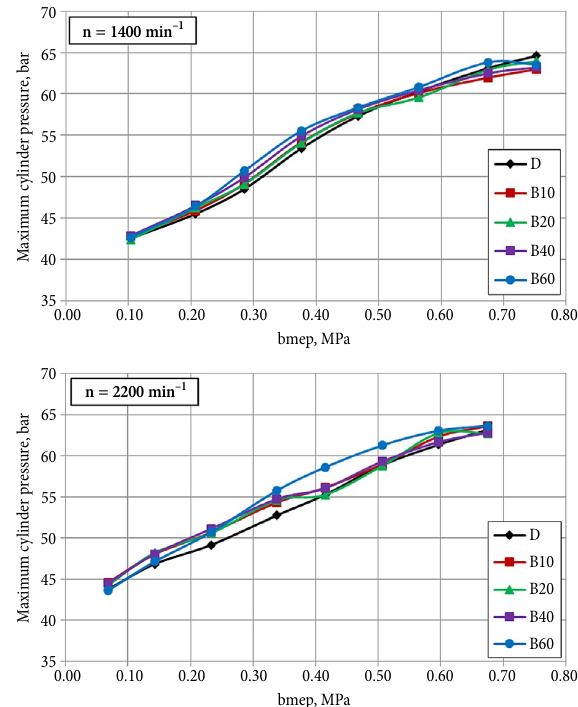
Fig. 4. Dependence of the in-cylinder maximum pressure ( p max ) on engine load ( bmep